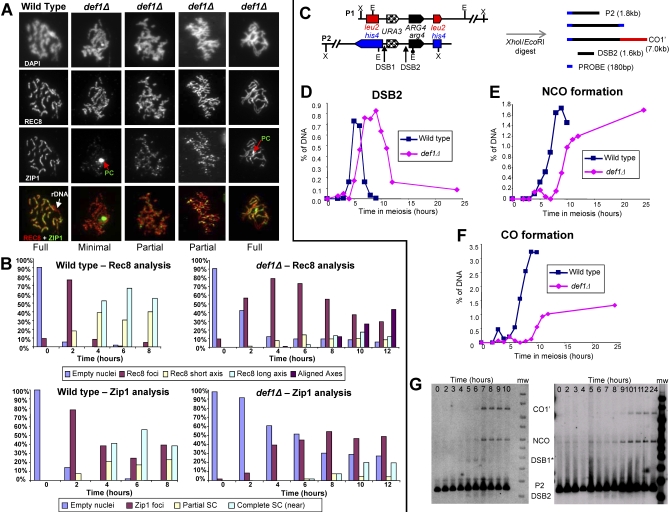
Assessment of def1Δ in Meiosis and Mitosis(A) Immunocytology of nuclear spreads of SK1 wild-type and def1Δ strains after 8 h of sporulation. The meiosis-specific subunit of cohesin, Rec8, was tagged with multiple Haemagglutinin (HA) epitopes. Using antibodies for HA and Zip1 allowed analysis of sister chormatid cohesion and synaptonemal complex formation, respectively. It can be seen in the wild-type example that all 16 chromosomes have long cohesin axes and close to full chromosome synapsis except for the rDNA region on Chromosome XII. Whereas from the first panel for def1Δ it can be seen that axes are aligned but synapsis is minimal. The second and third panels for def1Δ again show aligned axes, but homologues are only partially synapsed. However, as shown in the final panel, synapsis was observed in some meiotic nuclei of the def1Δ strain. Polycomplexes (PCs) of Zip1 were observed in 20% of the nuclei counted for def1Δ at this time point whereas less than 1% PCs were observed for the wild type.(B) Time course of the meiotic nuclei counted using immunocytology for both wild type and def1Δ during meiosis. The def1Δ mutant synapsis phenotype represented in (A) was counted as “aligned” axes in the Rec8 analysis graph. At least 200 nuclei were counted per time point.(C) Ectopic URA3-ARG4 interval on Chromosome III described in Figure 3. XhoI and EcoRI restriction sites are indicated by “X” and “E,” respectively. To detect NCOs, COs, and DSBs, DNA is digested with XhoI and EcoRI then probed with HIS4 sequences (hisU; [44]).For graphs (D–F), wild-type and def1Δ are represented by blue squares and pink diamonds, respectively. The corresponding XhoI and EcoRI double digest Southern blots, the XhoI single digest Southern blots, together with the molecular analyses, are presented in Figure S5.(D) Molecular analysis for DSB (DSB2) signal/total lane signal from Southern blots of DNA extracted from synchronized meiotic cultures.(E) Molecular analysis for NCO (NCO1) signal/total lane signal from Southern blots of DNA extracted from synchronized meiotic cultures.(F) Molecular analysis for CO (CO1') signal/total lane signal from Southern blots of DNA extracted from synchronized meiotic cultures.(G) Southern blot of DNA isolated from wild-type and def1Δ SK1 strains containing the ectopic URA3-ARG4 interval on Chromosome III. DNA was digested with XhoI and EcoRI then probed to detect NCOs, COs, and DSBs; mw represents the 1-kb molecular weight marker (Fermentas).